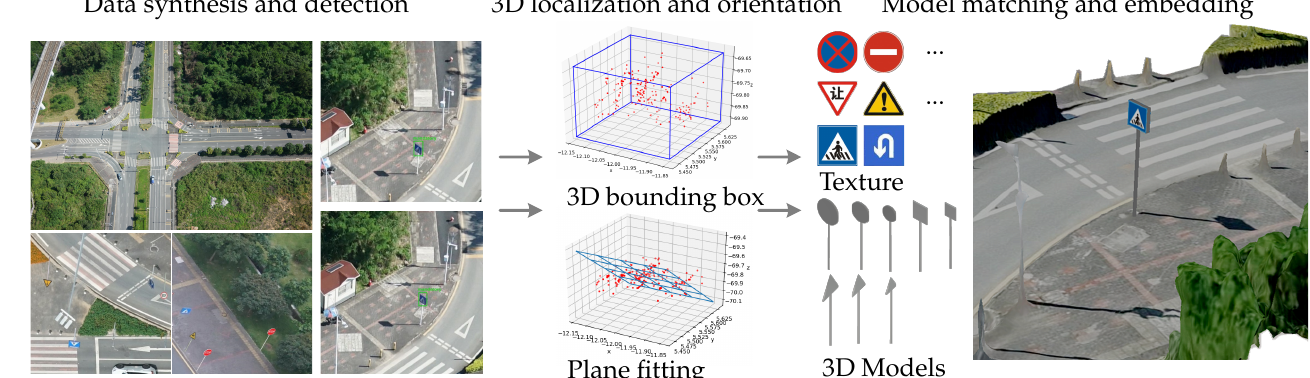
Figure 2. Overall framework of the proposed embedded modeling method.